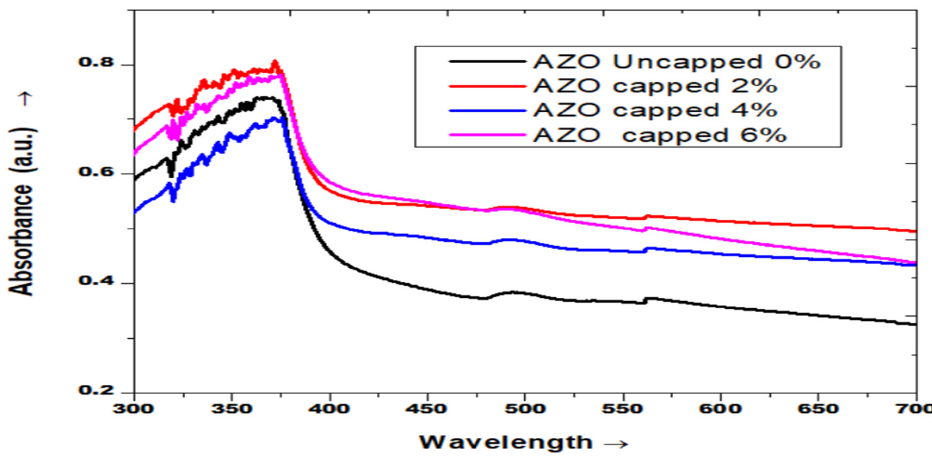
Figure 3. UV-Vis. absorption spectrum of AZO nanopowder with different Al concentrations.